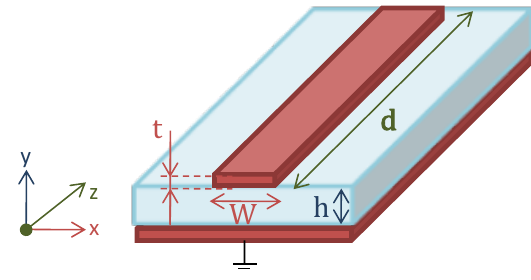
Figure 1: Geometrical representation of a microstrip